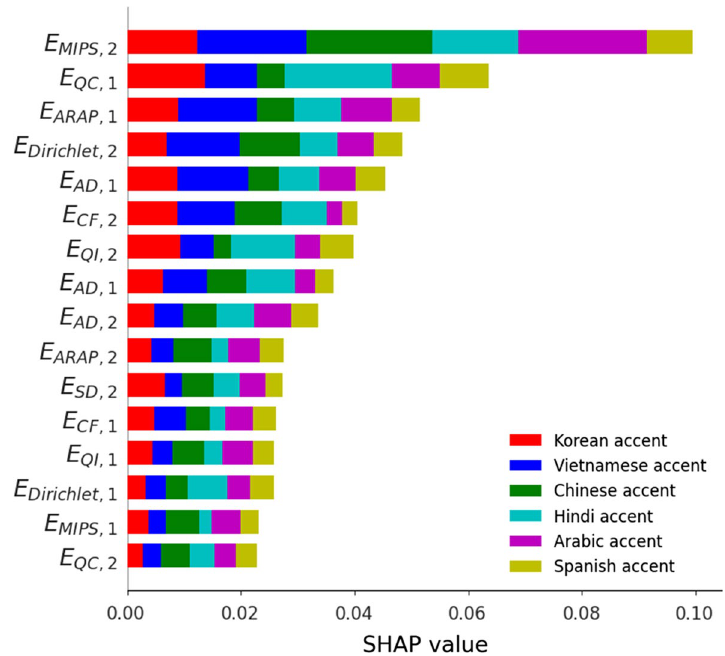
Fig. 10 Ranking of the distortions measures according to their SHAP values, per